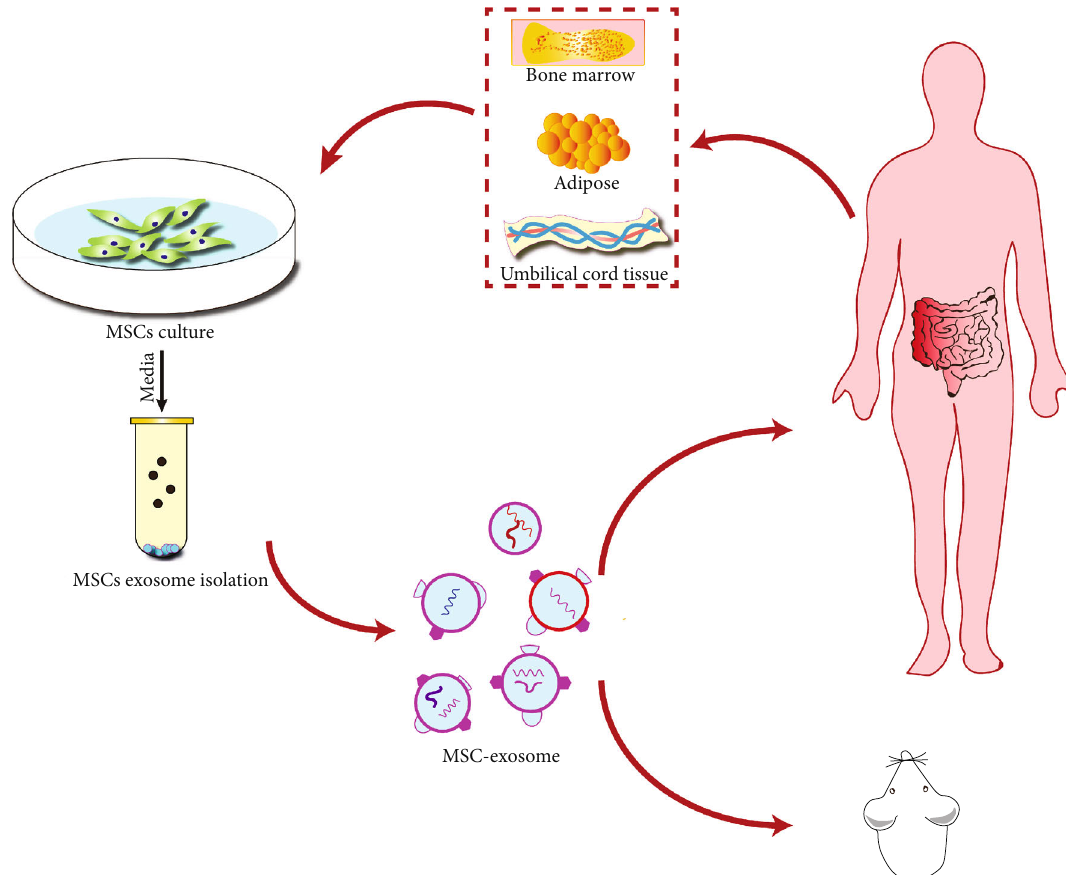
Figure 3: Schematic representation of IBD treatment using MSC-derived